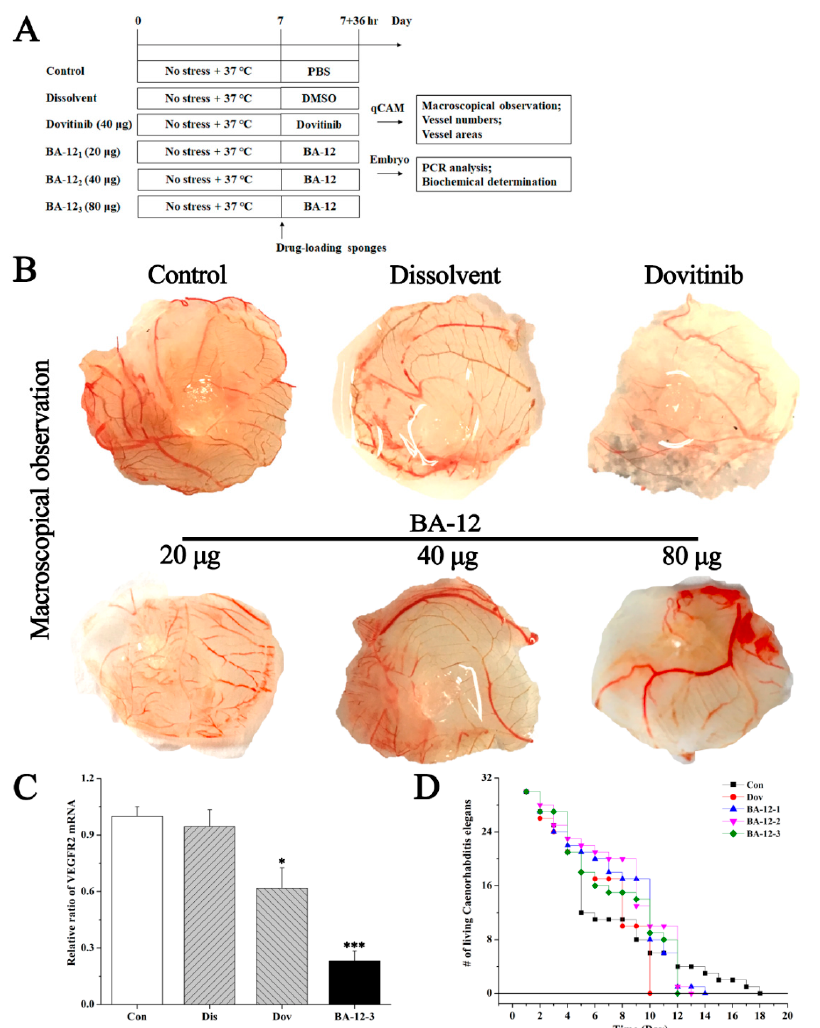
Figure 4. The effect of BA-12 on angiogenesis using a quail chick chorioallantoic membrane (qCAM) and human umbilical vein endothelial cells (HUVECs), and its biotoxicity based on a survival essay with Caenorhabditis elegans . ( A ) Schematic diagram of the experimental design. Con, control group treated with phosphate-buffered saline (PBS); Dis, dissolvent group treated with dissolvent containing 0.5% dimethyl sulfoxide (DMSO); Pos, positive control group treated with dovitinib (40 μ g); BA-12 1–3, groups treated with BA-12 at doses of 20, 40, and 80 μ g, respectively. ( B ) Inhibition of angiogenesis by BA-12 for qCAM assays in a dose-dependent manner. ( C ) Messenger RNA (mRNA) levels of vascular endothelial growth factor receptor 2 (VEGFR2) in qCAM samples. The most representative fields are shown. ( D ) Survival assay using Caenorhabditis elegans for biotoxicity detection. ANOVA with a post hoc test was used to calculate the significance of the differences; * p < 0.05, *** p < 0.001 compared with the dissolvent group. Experiments were executed three times. Results are displayed as means ± SD.